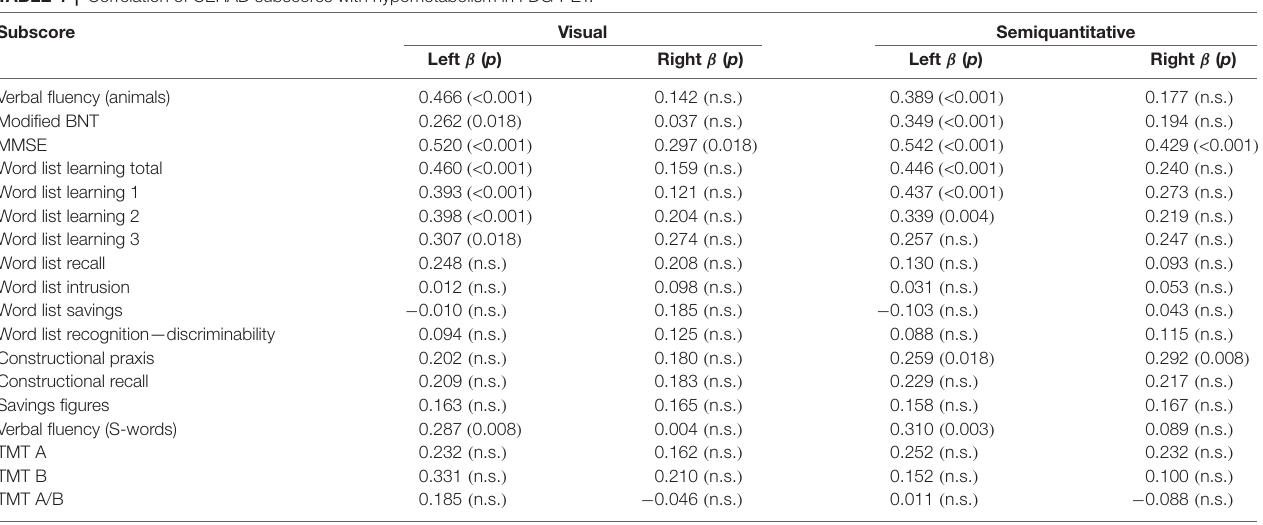
TABLE 4 | Correlation of CERAD subscores with hypometabolism in FDG-PET. Subscore Visual